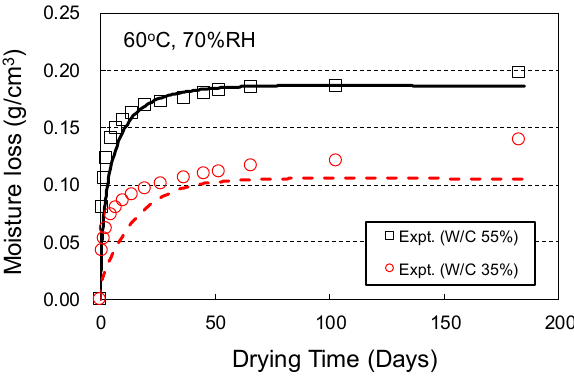
Figure 24. Comparison of weight loss based on the extensive model (W/C = 35%, 55%) [28].